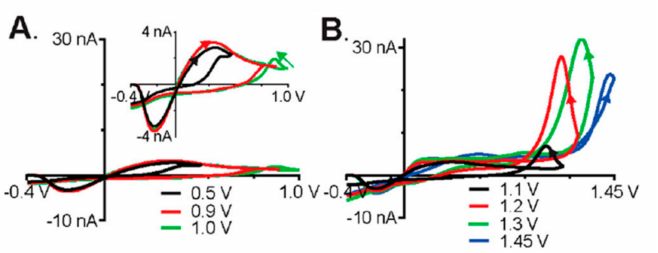
Figure 3. Fast scan cyclic voltammetry (FSCV) of 1 µ M histamine at di ff erent switching potentials, a holding potential of − 0.4 V, and a scan rate of 400 V / s. ( A ) Peak current as the result of electrostatic adhesion of histamine. ( B ) Faradaic peaks upon the reduction of histamine. Reprinted with permission [35].